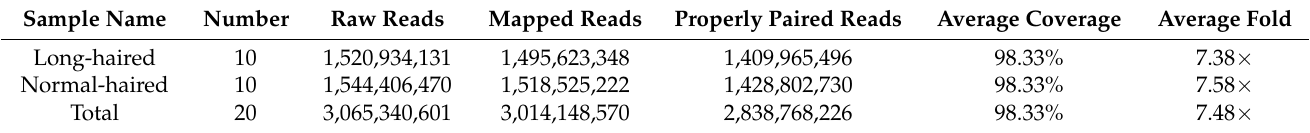
Table 1. Summary statistics of resequencing reads.